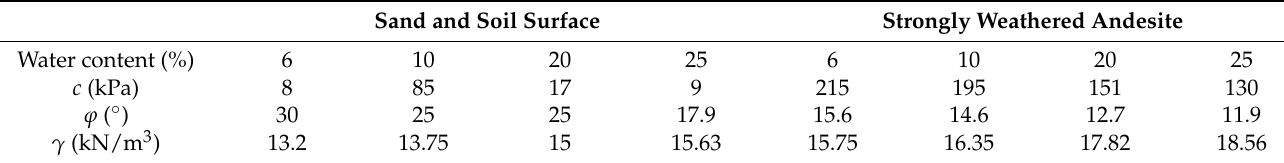
Table 6. Shear strength of rock mass varying with water content. Table 7. Prediction results of